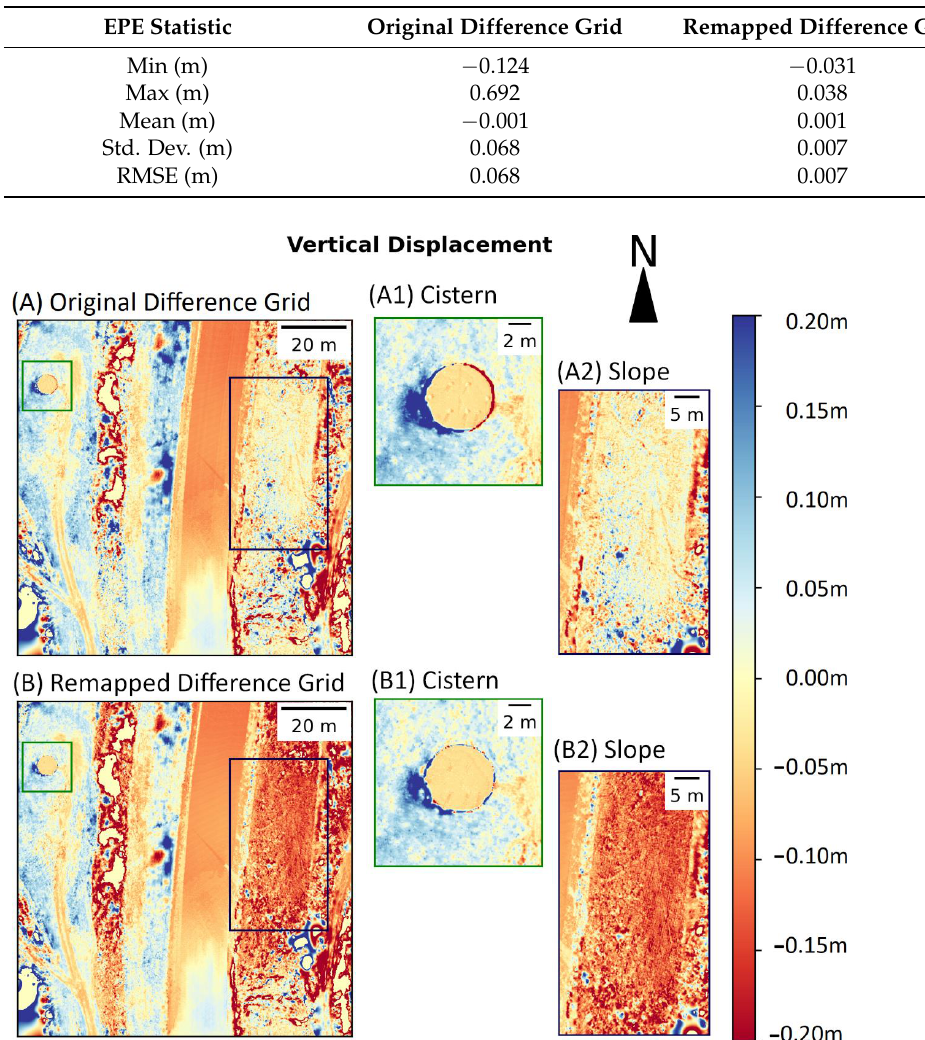
Table 6. Vertical accuracy of computing the vertical difference grid with and without using the proposed remapping approach, reported as the difference in meters compared to the ground truth.